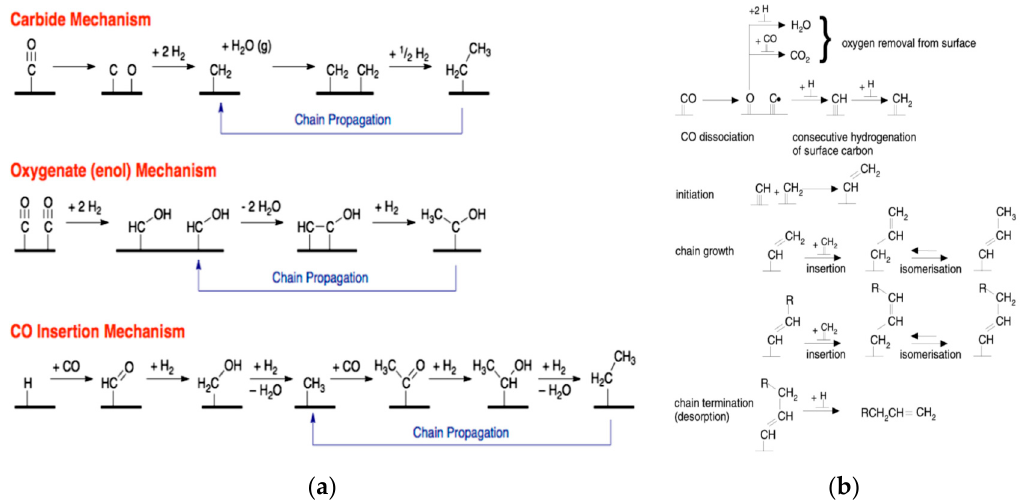
Figure 3. Schematics of chain growth in FTS. ( a ) Carbide, enol, and CO insertion mechanism; ( b ) alkenyl mechanism. Reprinted with permission from [4,5]. Copyright (2015) Academic Press Inc. Elsevier Science, San Diego, CA, America.